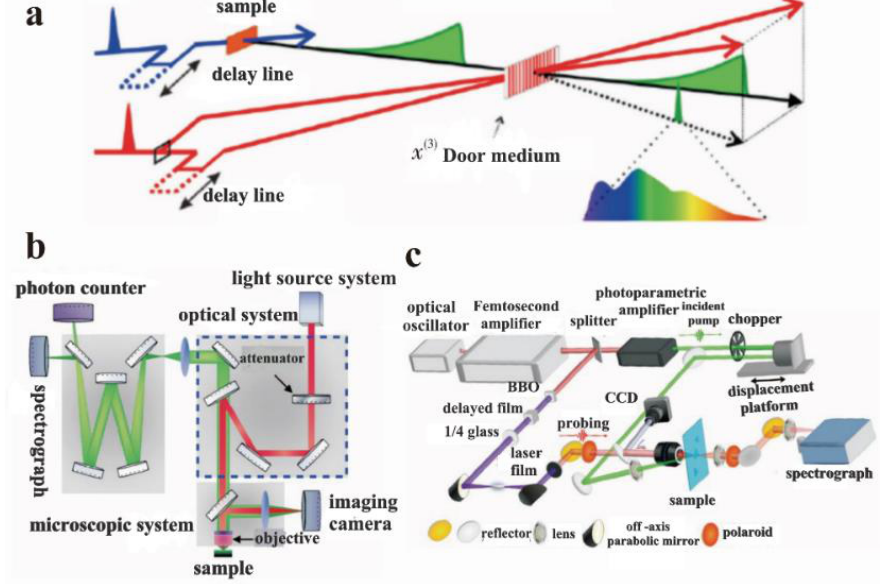
Figure 12. Structure diagram of partial spectral technique. ( a ) Transient fluorescence spectra. ( b ) Single-photon counting time-resolved fluorescence system. ( c ) Transmission transient absorption spectrum detection system. Adapted with permission from [71]. Copyright 2017, Electro-Optic Technology Application.